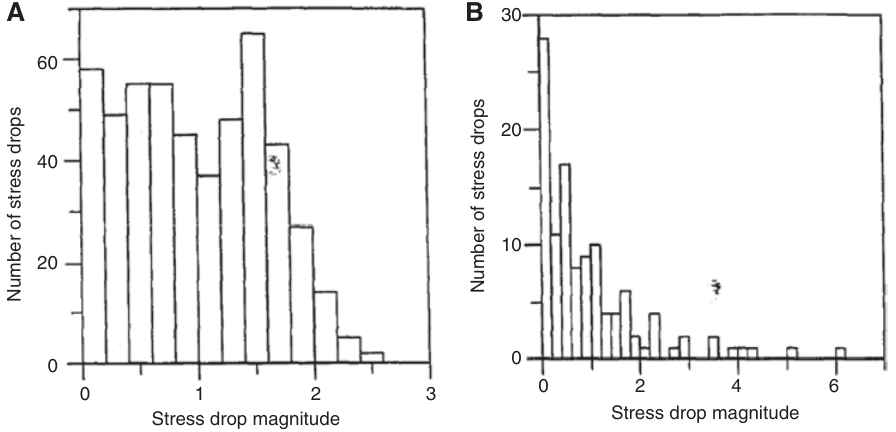
Figure 6: Simulated statistical distribution of the stress drops vs. different stress drop